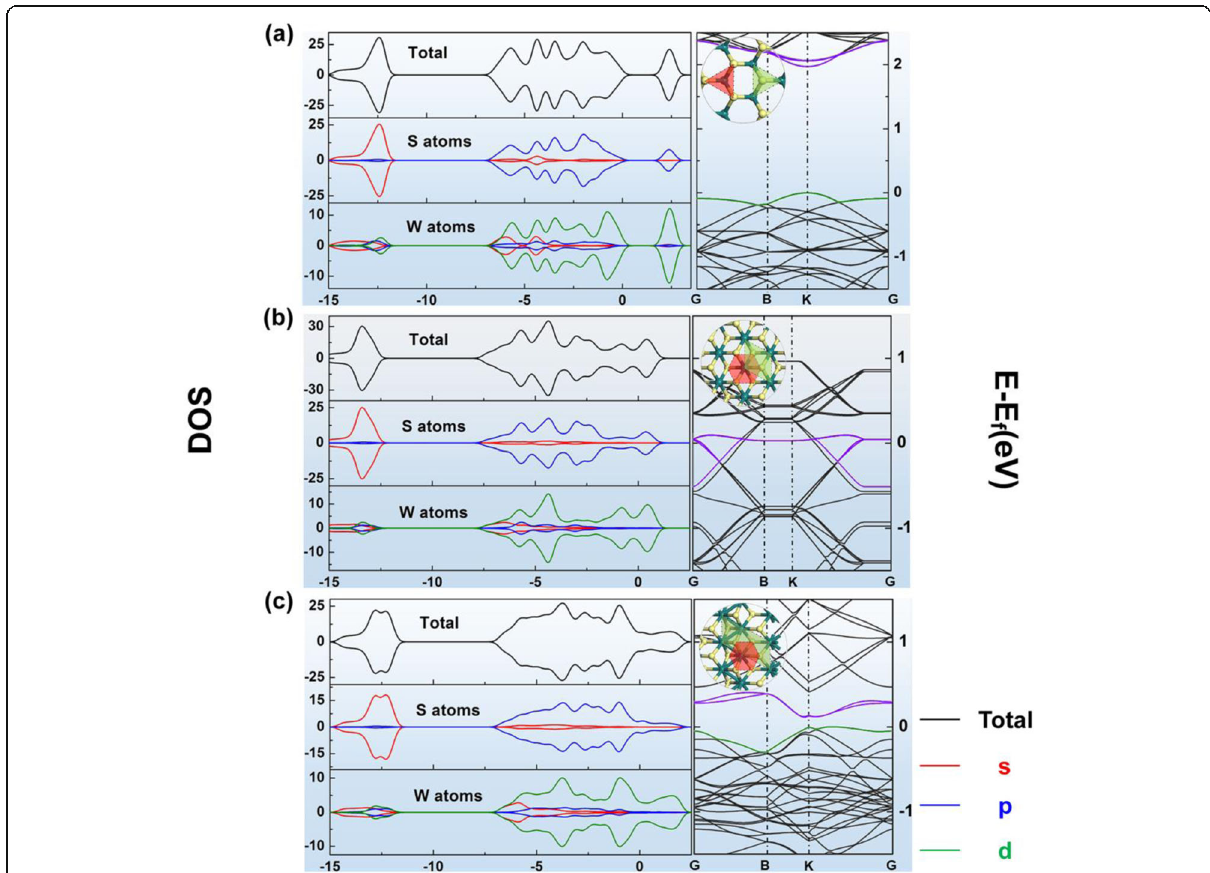
Fig. 1 Geometry structure, DOS, and band structure results of a 2H-WS 2 , b 1T-WS 2 , and c 1T ′ -WS 2 ; yellow balls represent S, and glaucous balls represent